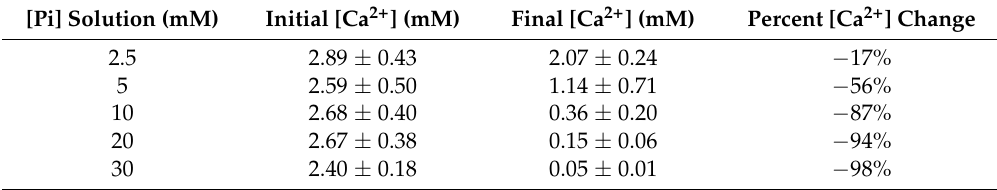
Table 2. Summary of [Ca 2+ ] results for the batch, unseeded precipitation tests.